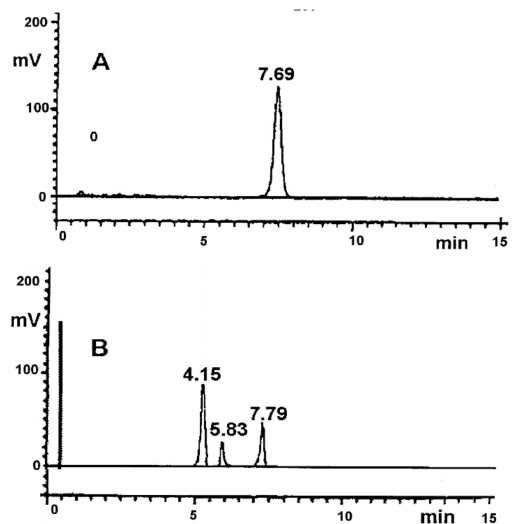
Figure 1. HPLC chromatograms: ( A ) pure RAM in non-degraded sample; ( B ) pure RAM after